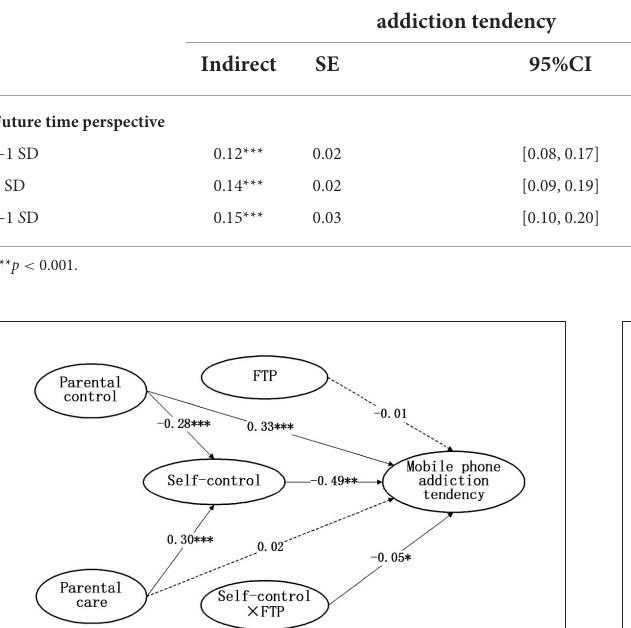
FIGURE2 The moderated mediation analysis of self-control on the relationship between parental control and parental care and adolescents’ mobile phone addiction tendencies conditioned by FTP.